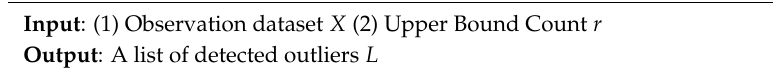
Algorithm 1. Generalized Extreme Studentized Deviate Test